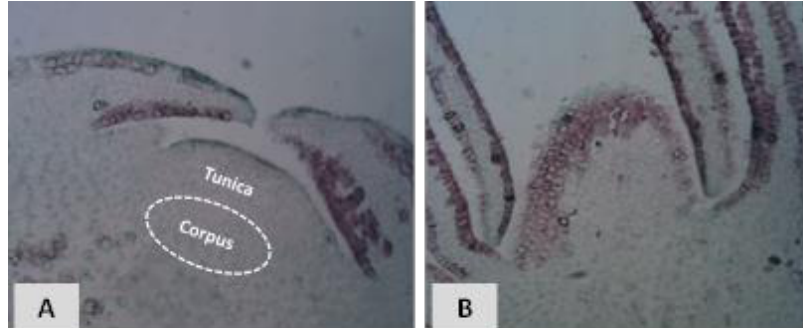
Figure 4. Developmental stages observed in meristematic apices of ‘Portici’ apricot cultivar. ( A ) Stage A ( × 200): undifferentiated meristematic apex constituted by an external and internal zone, namely ‘tunica’ and ‘corpus’, respectively. ( B ) Stage B (×200): differentiated meristematic apex constituted by a raised dome representing the receptacle primordium arrangement.